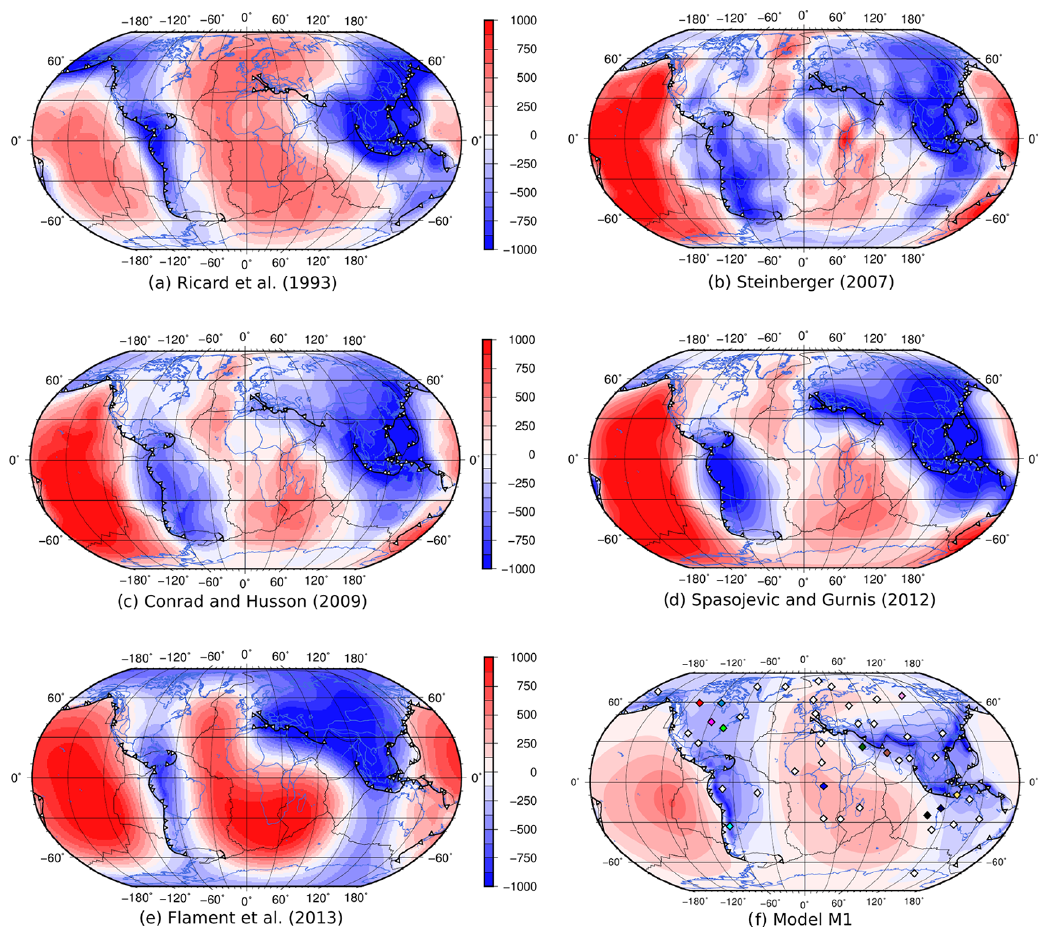
Figure 5. Comparison of present-day global dynamic topography as inferred from published mantle convection models: (a) Ricard et al. (1993), (b) Steinberger (2007), (c) Conrad and Husson (2009), (d) Spasojevic and Gurnis (2012), (e) Flament et al. (2013) and (f) our model M1. All grids display dynamic support that has been corrected for air